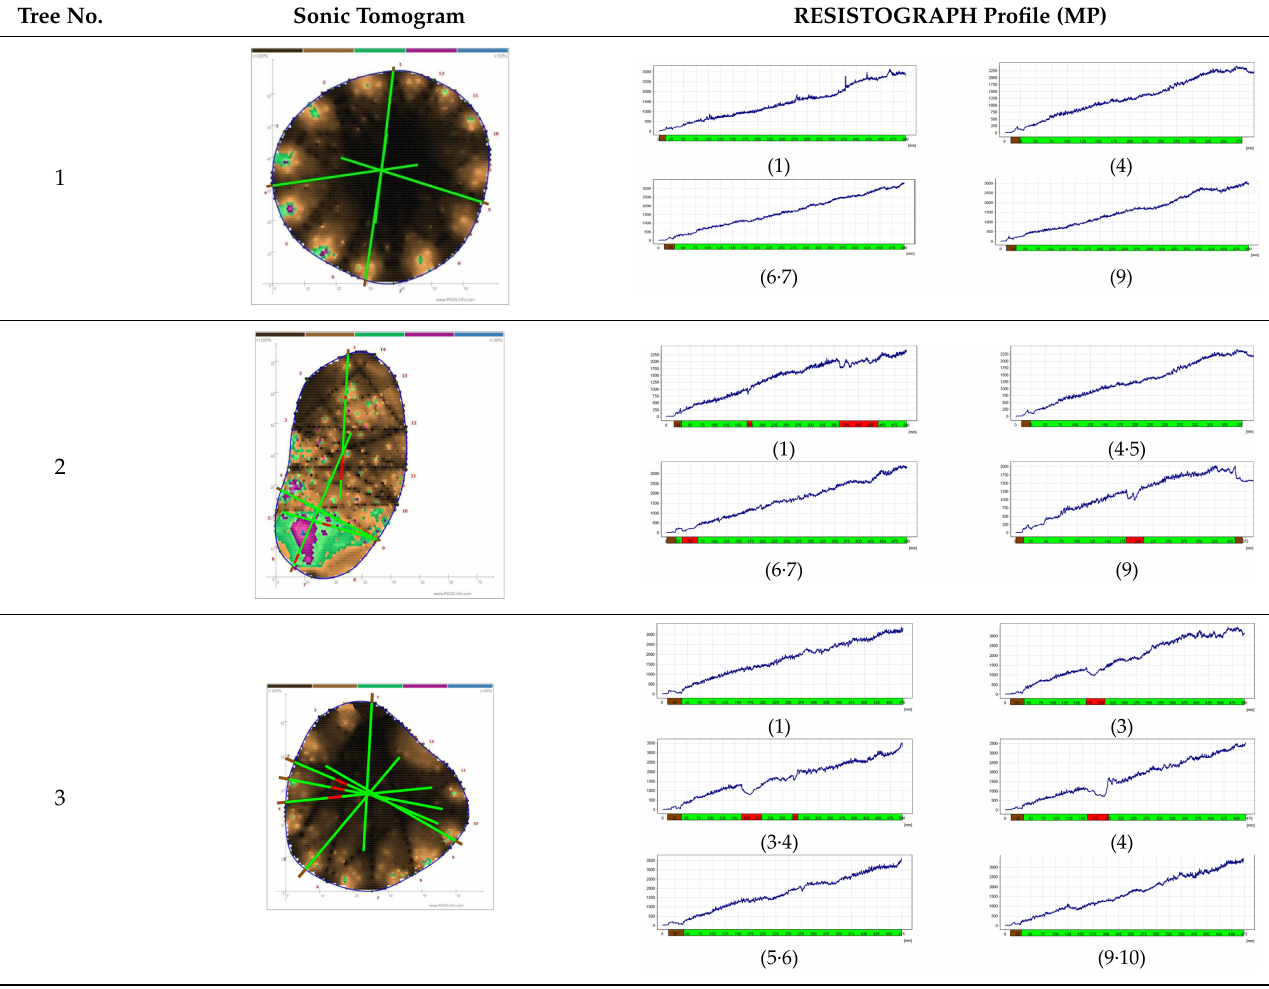
Table A1. Sonic tomograms superimposed with the RESISTOGRAPH profile table. (In the sonic tomograms and resistance profiles graphs, green lines indicate the depth of the drilling path and sound region, red lines represent the depth of the decay region, and brown lines represent bark. In the sonic tomograms, brown: healthy woods, red and blue: defects, green: initial decays). Tree